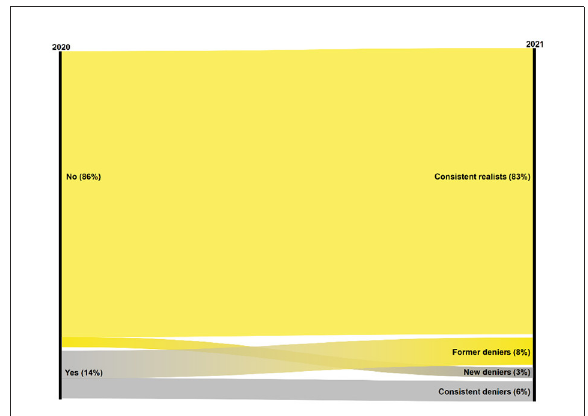
FIGURE1 Dynamics of Corona denial: changes from 2020 to 2021. The figure presents the relative frequencies (%) of yes-no responses to the hoax item in 2020 and how these changed in 2021. See section “Variables” for the exact item wording item and an elaboration of the four-fold typology in 2021.